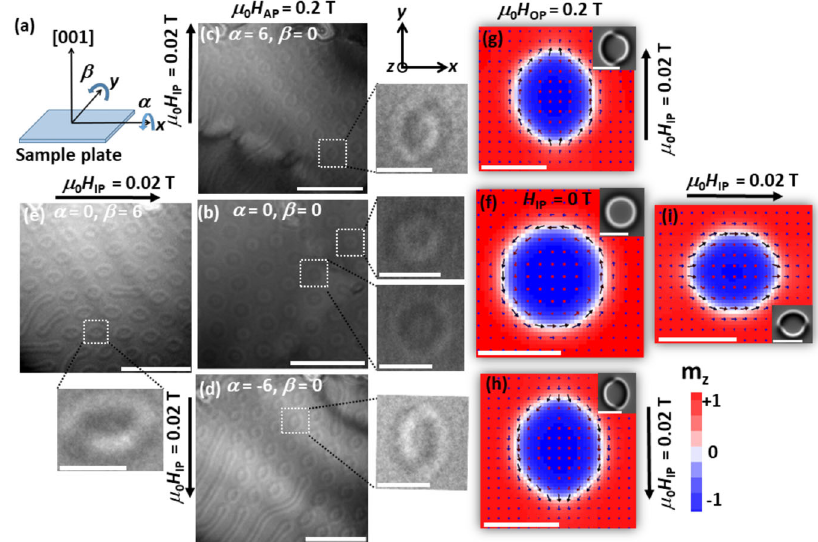
Fig. 4 Evolution of magnetic domains with controlled tilting condition. a Schematic diagram of the sample orientation to describe the tilting geometry. b – e The over-focused Lorentz transmission electron microscopy (LTEM) images taken at different tilting angles. All images are recorded at applied magnetic fi eld (H AP ) of 0.2 T and temperature T = 250 K. The scale bar shown in the images ( b – e ) corresponds to 500 nm. Scale bars shown in the zoomed view of fi gure ( b – e ) represent 100 nm. f – i The Object Oriented Micromagnetic Framework (OOMMF) simulated magnetic structures with different in-plane magnetic fi eld directions along with a fi xed out-of-plane magnetic fi eld of 0.2 T. The insets of ( f – i ) represent the LTEM simulated images corresponding to the OOMMF images. The scale bars shown in fi gure ( f – i ) and their insets correspond to 100 nm. The color bar represents the strength of the magnetic moment in z direction. Black arrows in the simulated images represent the in plane magnetization components. The extended fi gures corresponding to ( f – i ) are shown in the “ Supplementary Note 4''. H corresponds to the magnetic fi eld and μ 0 is the permeability of